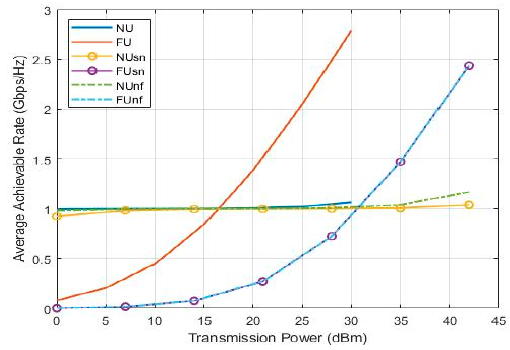
Figure 10. Achievable rate vs. transmit power .